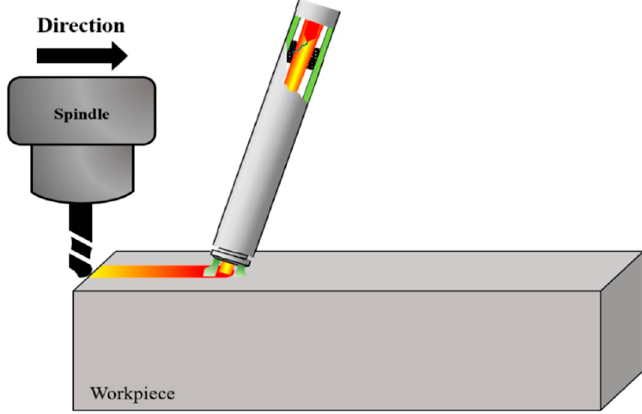
Figure 1. Schematic diagram of the plasma assisted machining (PAM).